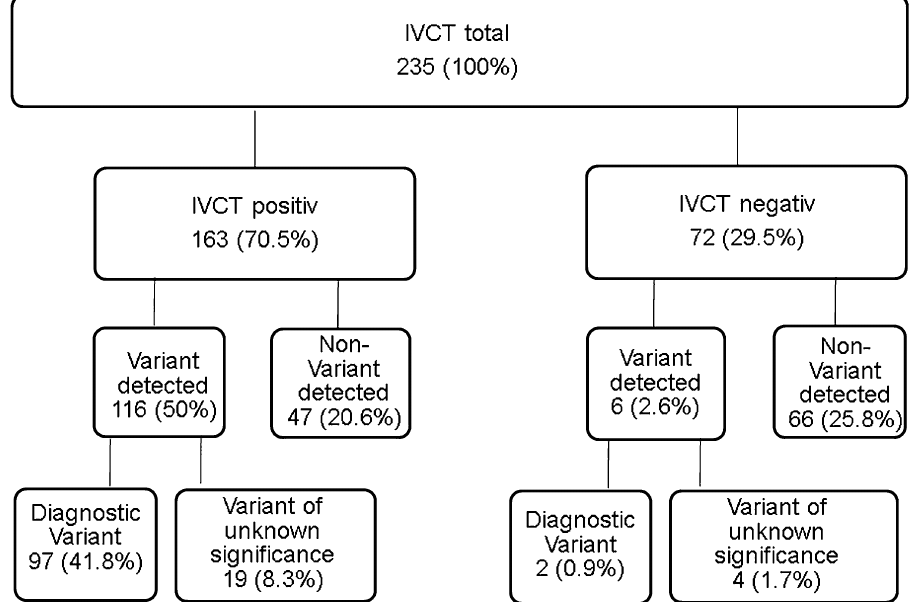
Figure 1. Results of all tested individuals. A total of 235 individuals with a history of clinical malignant hyperthermia or close relatives were functionally analysed by the in-vitro contracture test (IVCT) and genetically screened. The detected variants were divided into known pathogenic variants and variants of unknown significance. For classification as being pathogenic, each variant has to be fully characterized at the genetic level, including co-segregation of the variant with the disease in the family affected. Moreover, functional assays have to show that a variant in the RyR1 or CACNA1S gene results an effect consistent with the MH phenotype. All other variants are classified as variant of unknown